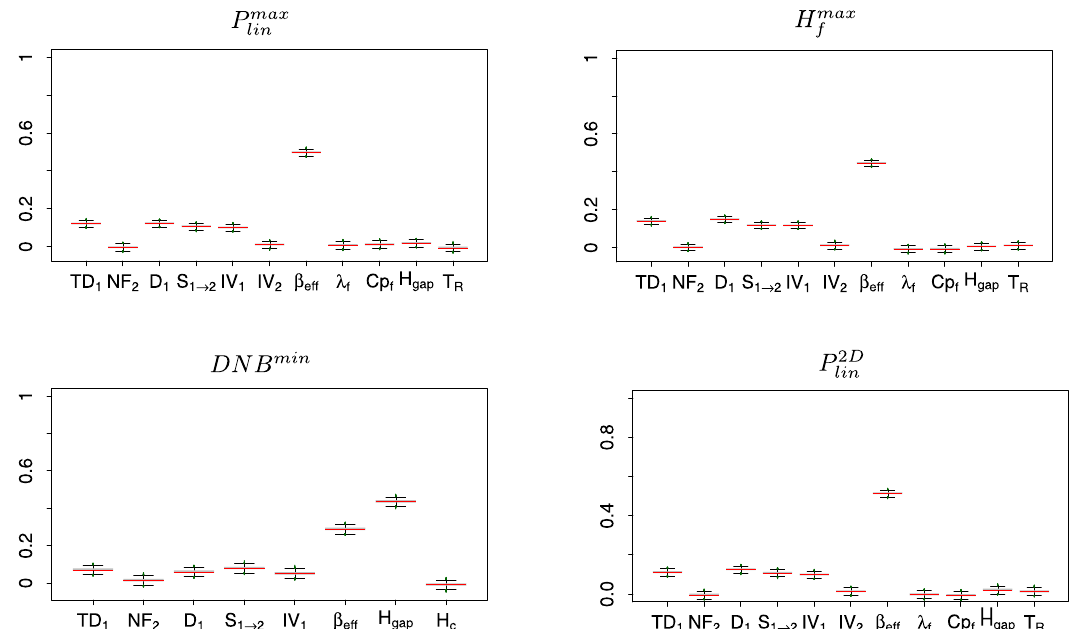
Fig. 6. P max and DNB min Shapley indices and P 2 D , H max f lin